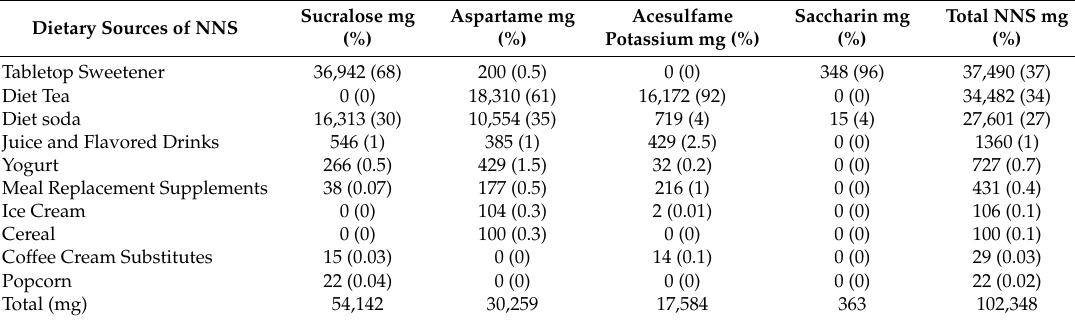
Table 3. Contribution of dietary sources to absolute non-nutritive sweetener (NNS) mg intake among NNS consumers ( n = 100).